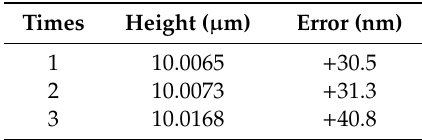
Figure 8. Accuracy verification of probe. Table 2. The results of an accuracy verification of the probe.